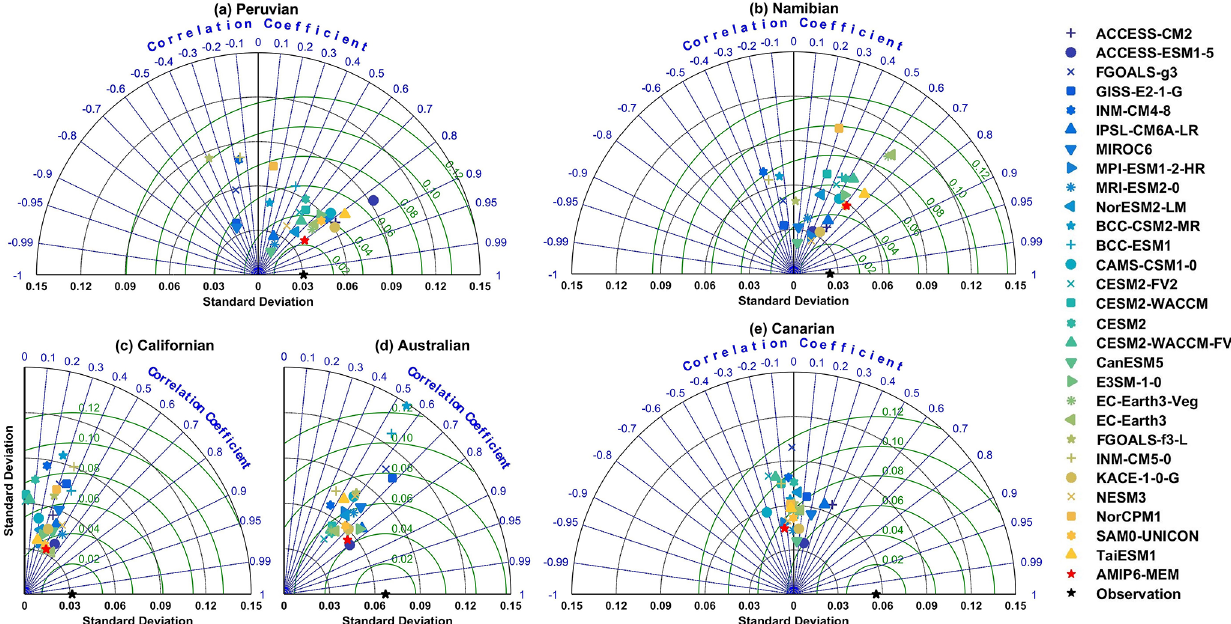
Figure 4. Taylor diagrams for monthly estimated cloud albedo between individual AMIP6 models and satellite observations during 2003– 2014 over the (a) Peruvian, (b) Namibian, (c) Californian, (d) Australian and (e) Canarian regions. The green circles indicate the centered root mean square